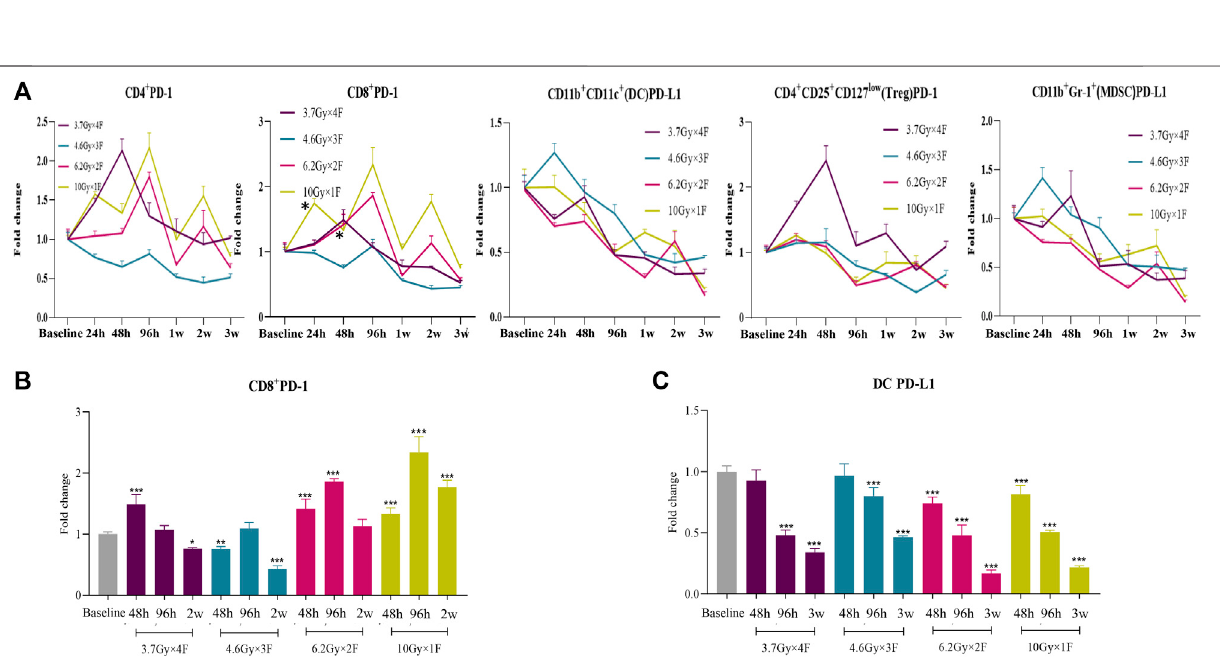
FIGURE 2 | Dynamic changes of immune cell counts in LLC implanted mouse peripheral blood after radiotherapy. (A) Trends of CD4 + T cells, CD8 + T cells, DC, Treg, and MDSC after 4 different fractionation radiotherapies. * The dose in which trend was signi fi cant and the time at which difference began. (B) Changes of CD8 + T cells at 48 h, 96 h, and 3w after radiotherapy, respectively. (C) Changes of DC at 1, 2, and 3w after radiotherapy. * p ＜ 0.05,** p ＜ 0.01, *** p ＜ 0.001, compared with baseline.